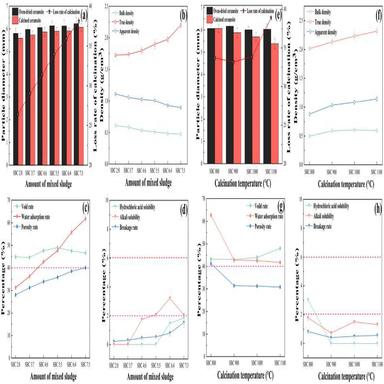
Optimization of process parameters for ceramsite preparation: (a)~(d) effect of dewatered municipal sludge; (e)~(h) effect of sintering temperature.